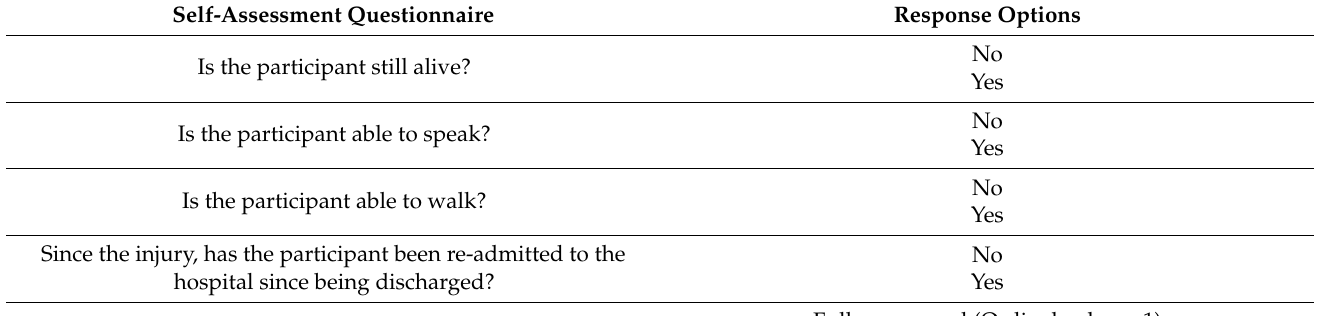
Table A1. Self-Perception